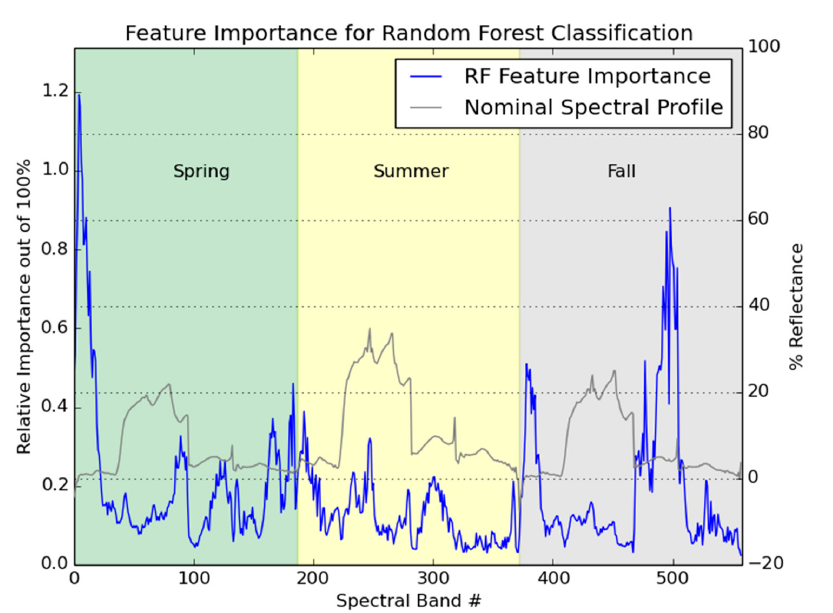
Figure A1. Feature importance for the three-season Random Forests classifier. Nominal spectral profile for ENT shown for context.